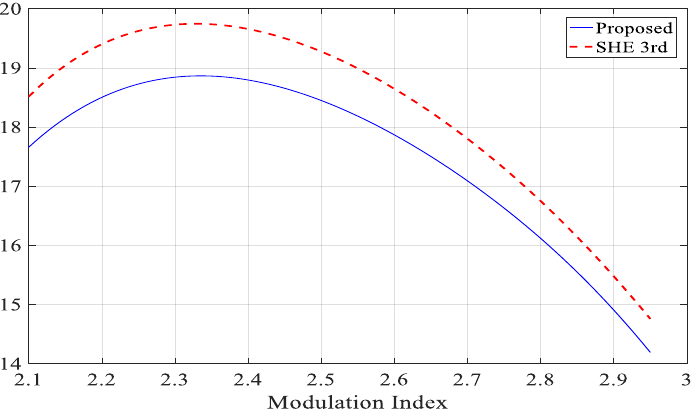
Figure 5. Curve showing variation between the Voltage THD in percent and modulation index for SHE of 3rd order harmonics and for the proposed technique.